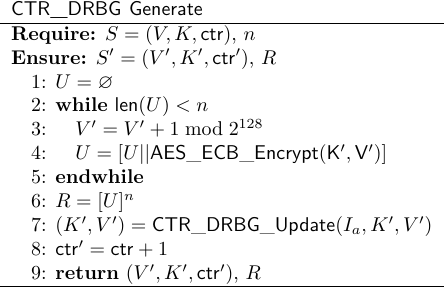
Figure 31: NIST CTR _ DRBG